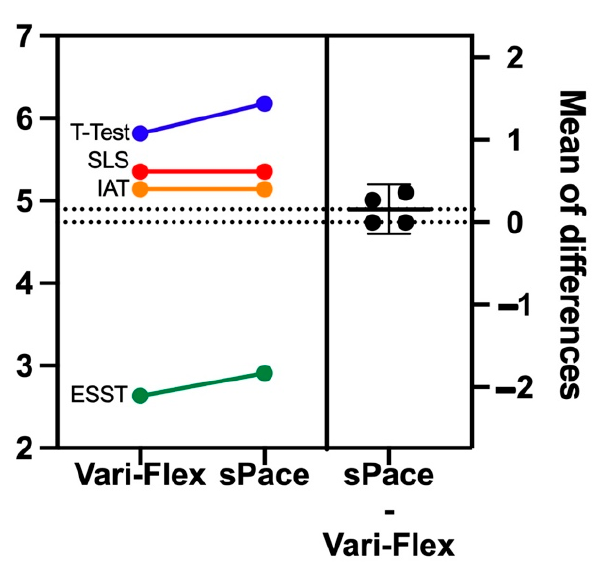
Figure 4. Mean differences of participants wearing sPace and Vari-Flex on CHAMP. Note: left panel is individual test differences for all participants, and right panel is mean differences between feet.